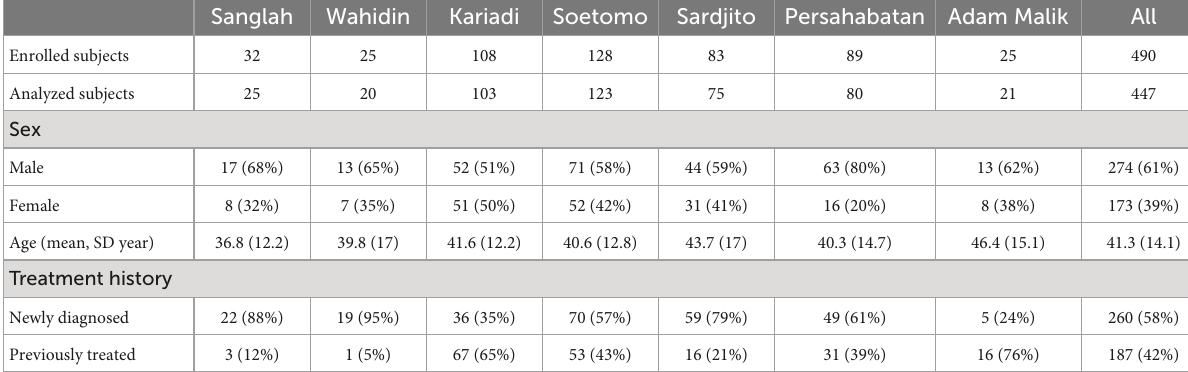
TABLE 1 The distribution of sex, age, and treatment history in each study site. Sanglah Wahidin